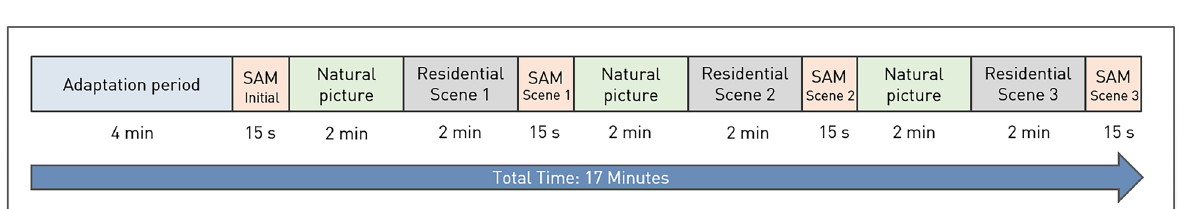
Figure 3. 360° pictures of residential areas shown during the virtual reality experiment, including an estimation of the amount of sky, built, and greenery based on pixel count percentages. Images treated with Affinity Photo 1.10.0.1127 (https:// affin ity. serif. com).